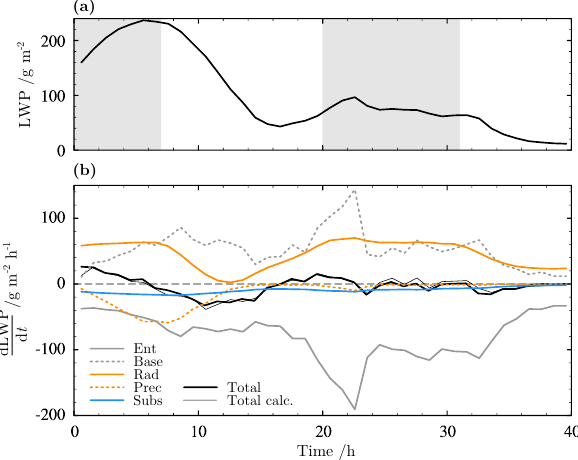
Figure 2. (a) The LWP as a function of time for the ASTEX tran- sition simulation. The gray shaded areas indicate nighttime condi- tions. (b) The tendency of the LWP as a function of time, split into the contributions from the individual physical processes according to Eq. (3). Line colors and styles according to the legend. The hor- izontal dashed black line indicates the zero tendency level as a ref-